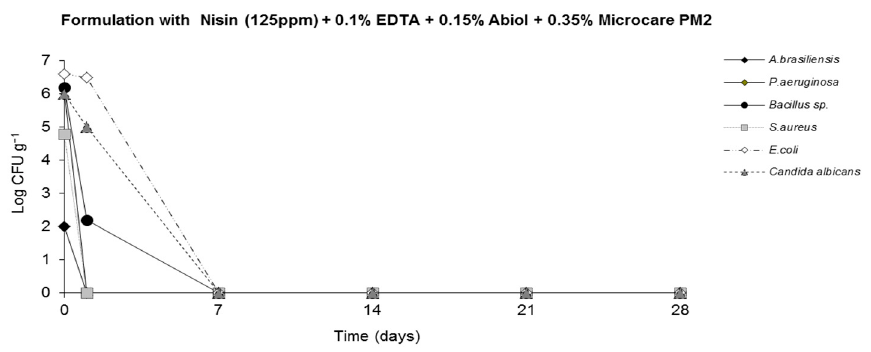
Figure 3. Growth inhibition of different microorganisms in body milk formulation with preservative system nisin 125 ppm + 0.1% EDTA + 0.15% Abiol + 0.35% Microcare PM2.